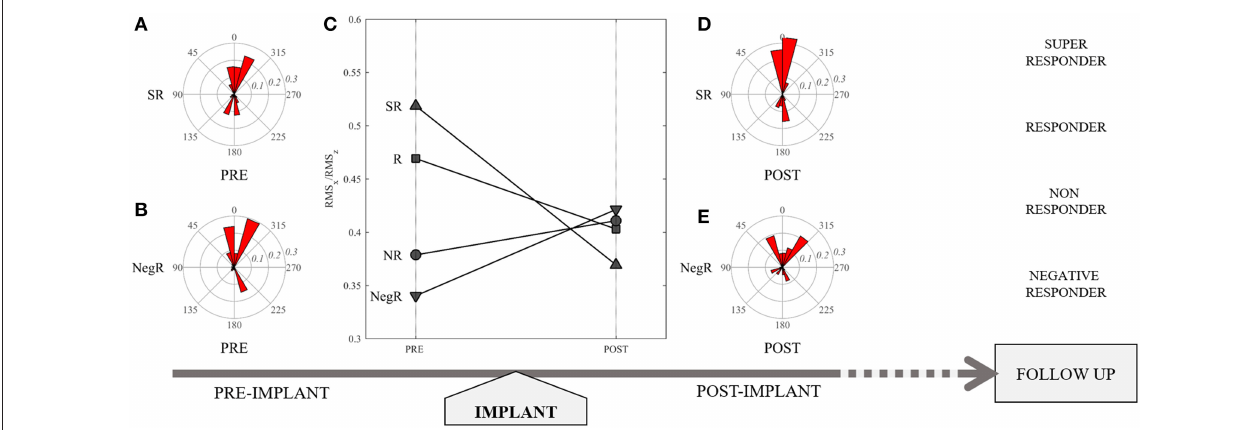
FIGURE 1 | Representation of study design: (C) patient’s categorization according to different values of RMSx/RMSz PRE CRT implant, and their variation POST CRT, which resulted representative of responder status at follow up. Polar representation of the distribution of hemodynamic forces in a Super Responder (SR) patient pre